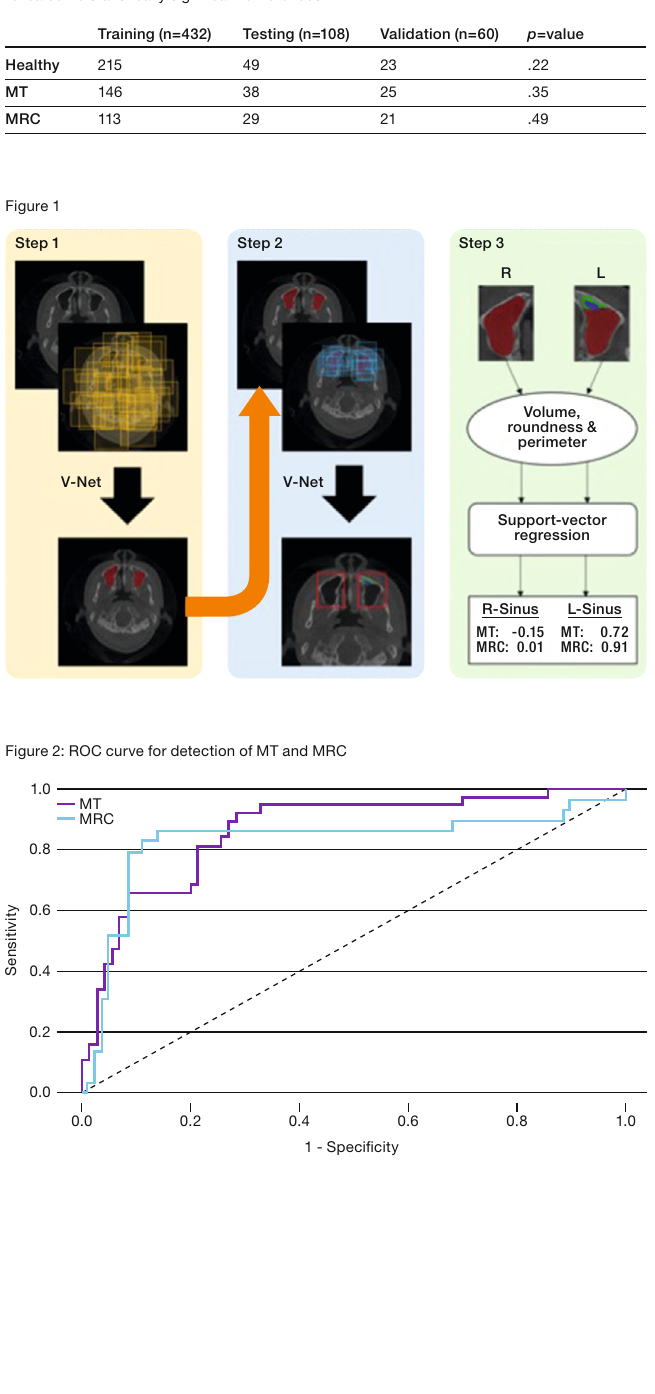
Table 1: Patients demographics. The numbers shown were counts of sinuses. Some sinuses have both mucosal thickening (MT) and mucosal retention cysts (MRC). Kruskal-Wallis revealed no statistically significant differences.